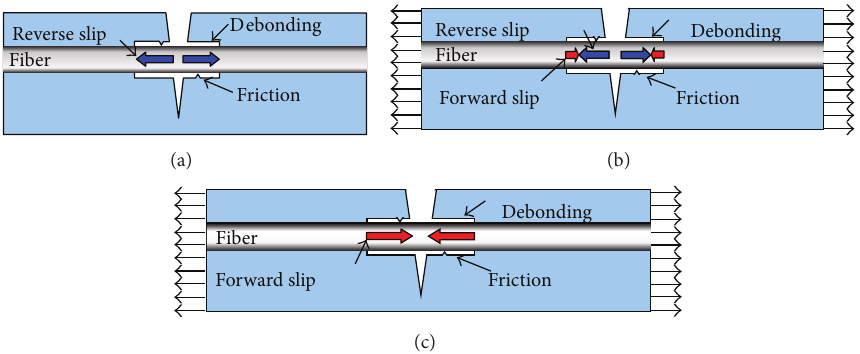
Figure 9: Slip transform for bridging fiber after reloading [16].